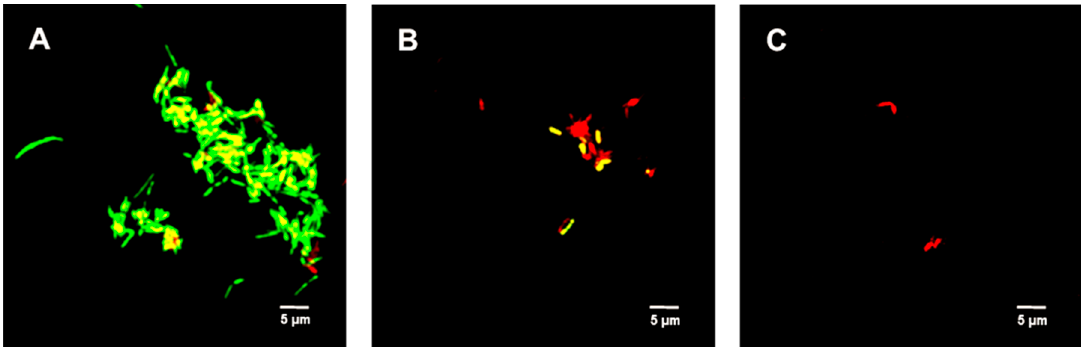
Figure 4. Live/Dead assay of M. smegmatis with various concentrations of TFDG at 6-h incubation. The samples were visualized using Olympus confocal microscope. The green indicates live bacteria, while the red indicates dead bacteria. ( A ) M. smegmatis control; ( B ) M. smegmatis with 62.5 µg/mL TFDG; and ( C ) M. smegmatis with 250 µg/mL TFDG.